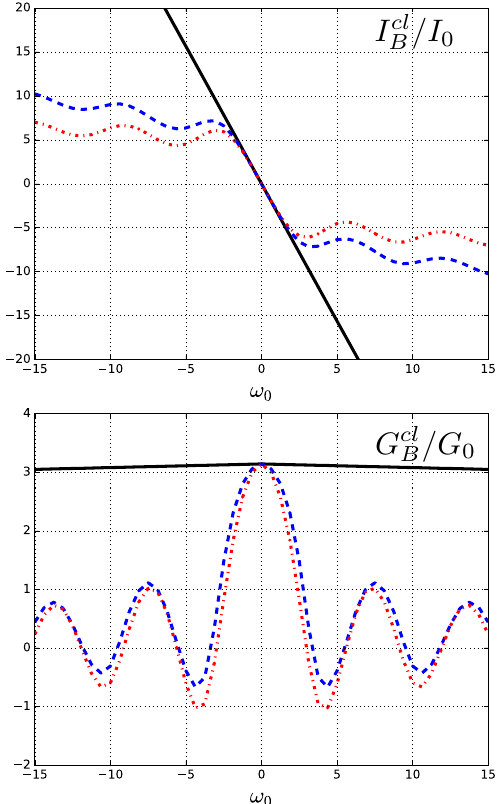
= e | Λ | 2 / ( π v τ ) 2 (top) and differential conductance Figure 3: Classical current in units of I ρ σ 0 = eI in units of G (bottom). Every curve is properly further rescaled with respect to the 0 0 factor ( ω ρ τ σ ) a j e − γ j in order to keep track of the interaction induced renormalization of the tunneling amplitudes for the non interacting case ( j = 0, full black curve), the one trapped channel case ( j = 1, dashed blue curve) and the two trapped channels case ( j = 2, dotted- = eV / ħ h . Parameters are: dashed red curve) as a function of the Josephson frequency ω 0 0 τ = 1, ω τ = 1000, | Λ | = | Λ | = | Λ | and ħ h = σ ρ σ 1 2